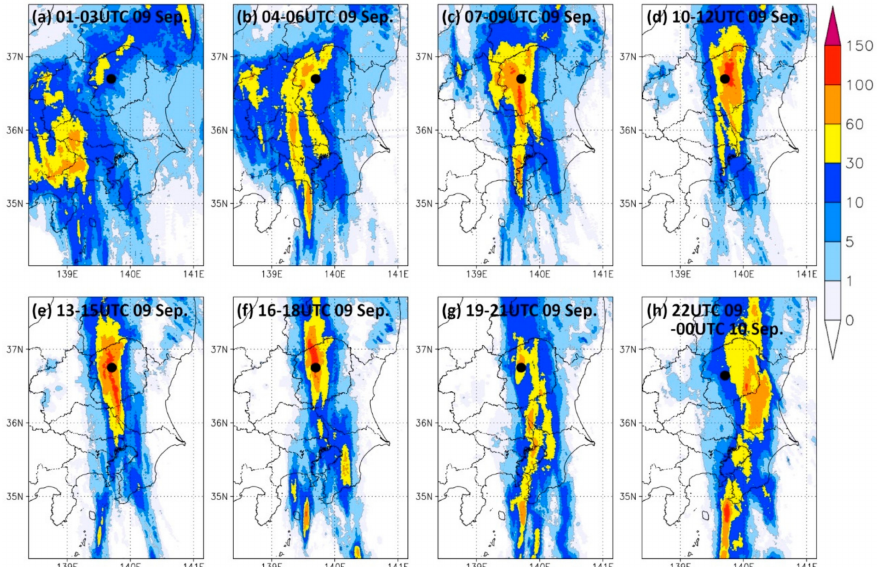
Figure 4. 3-hourly rainfall by Radar-AMeDAS precipitation (RAP). Result of ( a ) 01–03 UTC, ( b ) 04–06 UTC, ( c ) 07–09 UTC, ( d ) 10–12 UTC, ( e ) 13–15 UTC, ( f ) 16–18 UTC, ( g ) 19–21 UTC on 9 September. ( h ) Result of 22 UTC on 9 September–00 UTC on 10 September. The unit of the color bar is mm / 3 h. Filled black circle indicate the location of the Nikko city.